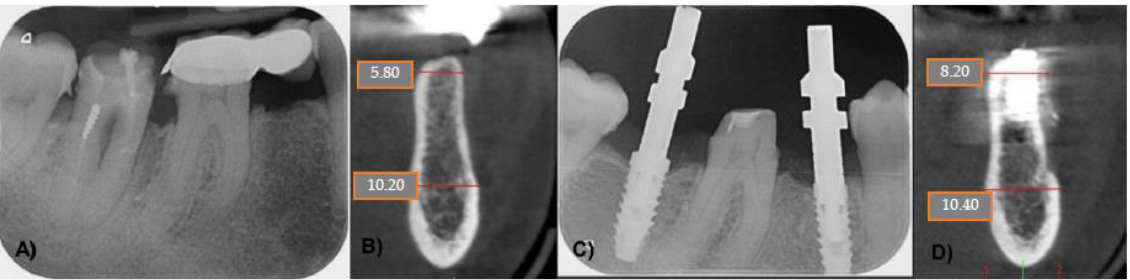
Figure 2. ( A ) Preoperative intraoral periapical radiograph (IOPA); ( B ) Initial CBCT; ( C ) Intraoperative IOPA; ( D ) CBCT after 4 months.